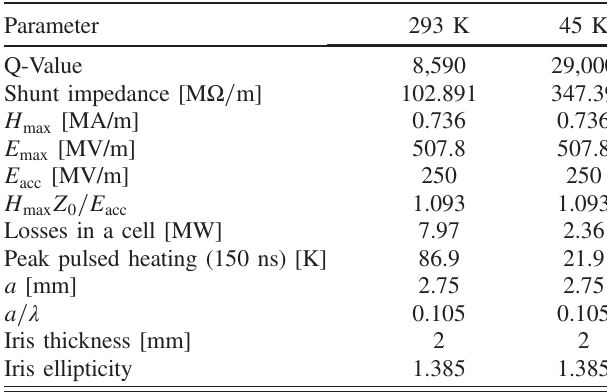
TABLE I. Parameters of periodic accelerating structure with π phase advance per cell and dimensions of the Cryo-Cu-SLAC middle cell at 45 K and 293 K. Fields are normalized to E 250 MV = m for f ¼ 11 . 424 GHz. Peak pulsed heating is calcu- 0 lated for a pulse with 150 ns flat gradient.